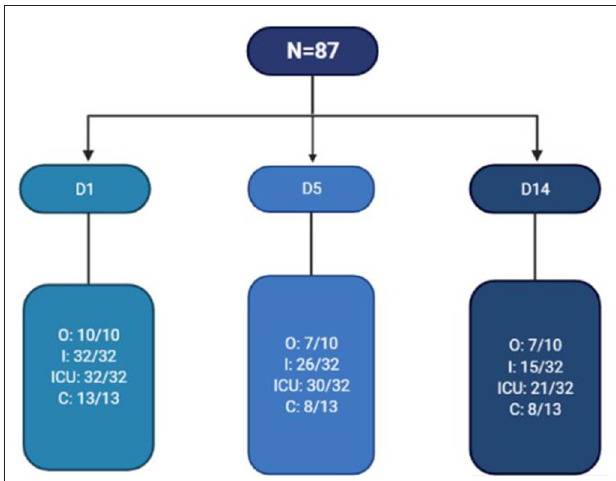
FIGURE 1 | Flow chart of blood samples collected in this study. N, number of patients; D1, D5, and D14, days 1, 5, and 14 of hospitalization,